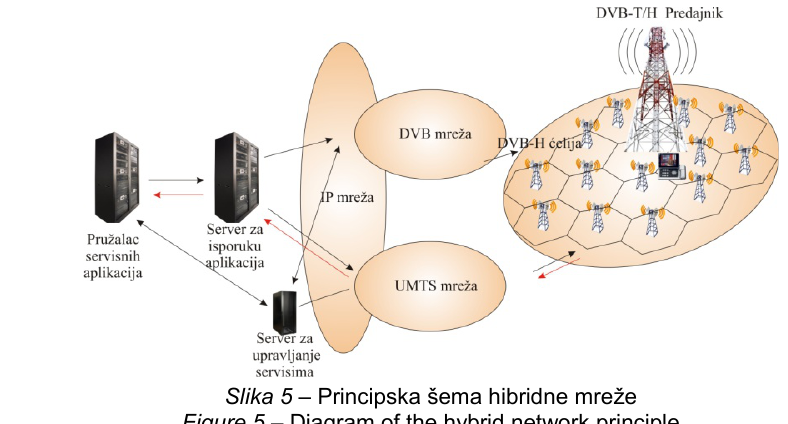
Figure 5 – Diagram of the hybrid network